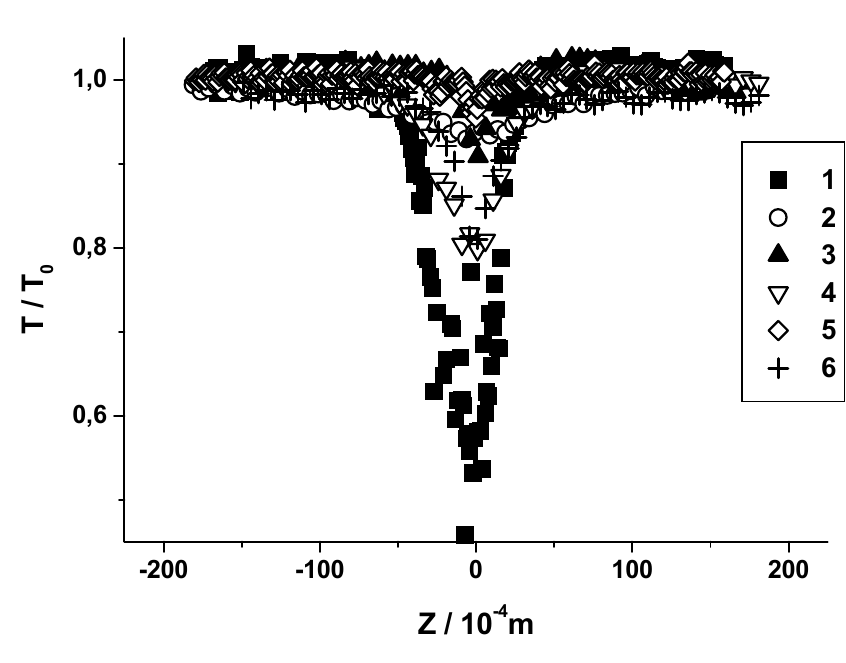
Figure 1. Z-scan profiles for the species (1)-(6). The species were irradiated at the same level. The of the examined solutions was 0.9. The concentrations were in the range 4-5* linear transmittance T 0 10 -5 M. The 1-chloronaphthalene solvent didn’t show any NLO behavior at the used level of